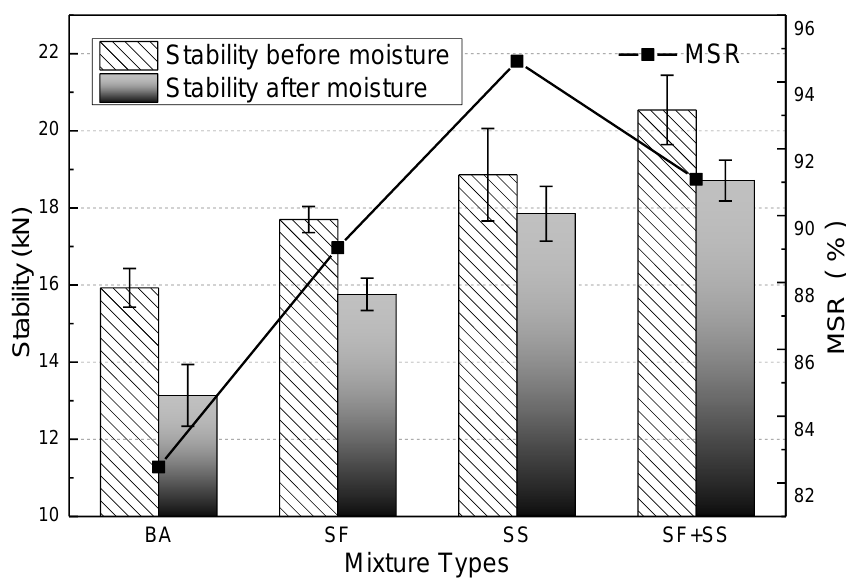
Figure 4. Marshall Stability and Marshall Stability Ratio (MSR) of different asphalt mixtures. SF: steel fibers.